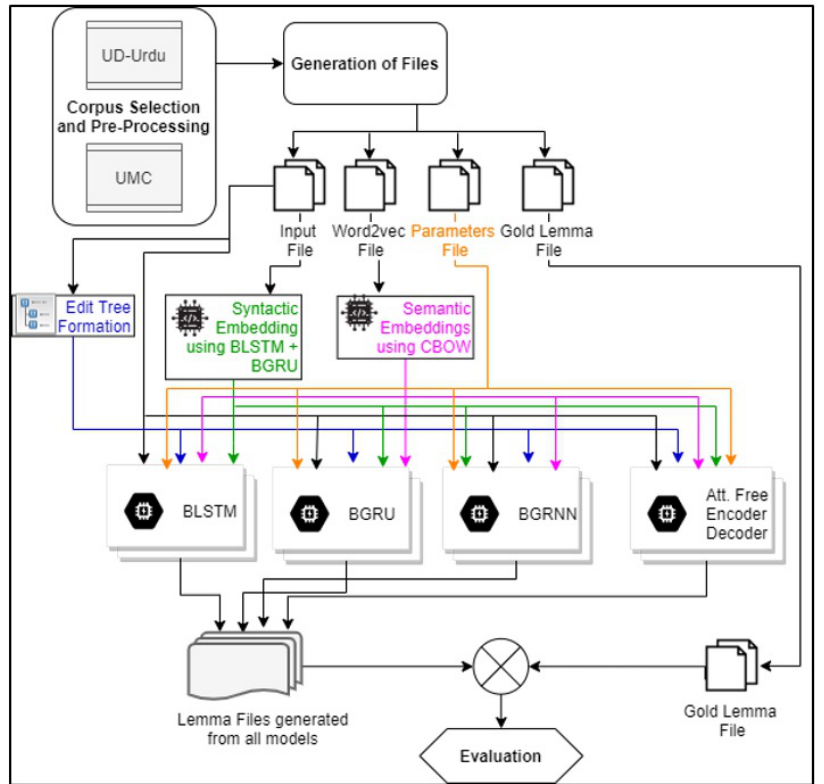
Figure 7. Layman architecture describing contextual Urdu lemmatization using RNN